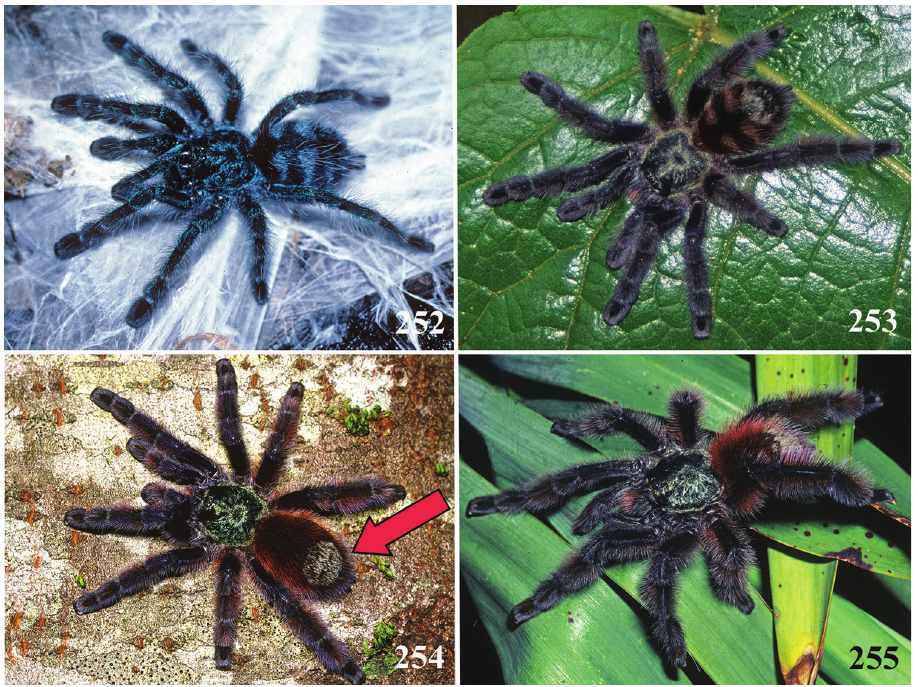
Figures 252–255. Caribena versicolor (Walckenaer, 1837) comb. n., habitus. 252 immature 253 juvenile 254 female 255 male. Arrow: urticating setae type II on conspicuous patch on dorsal abdomen. Photos: R. C. West.